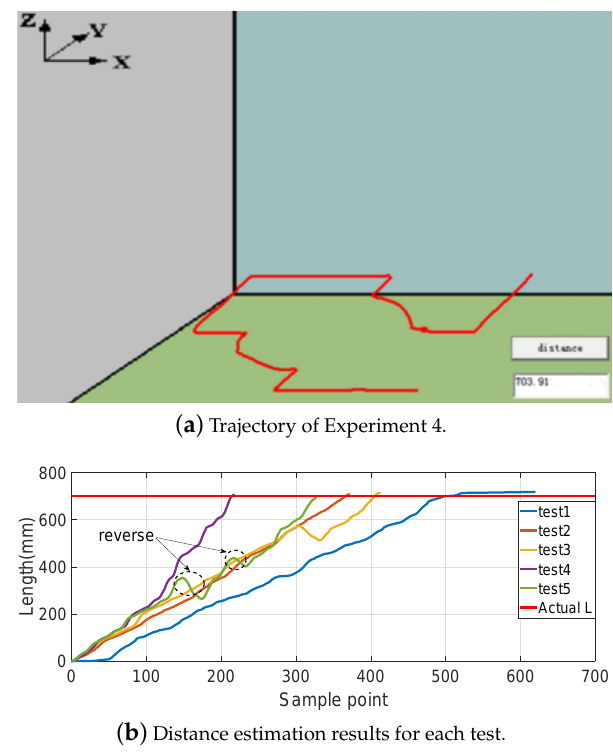
Figure 10. Experiment 3: a square path consisting of four straight lines with a length of 190 mm; total path length 760 mm.